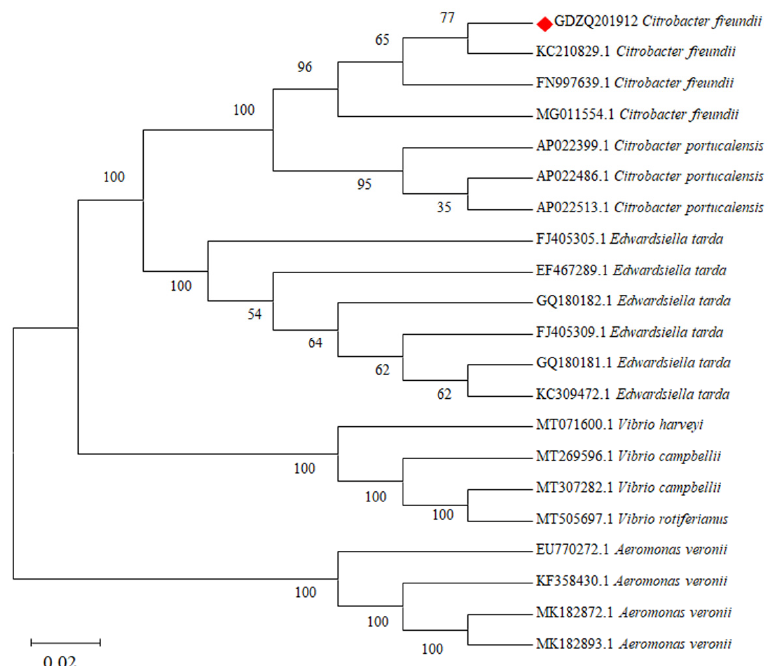
Figure 3. Phylogenetic tree analysis of Citrobacter sp. and other pathogenic bacterium species based on 16S rRNA nucleotide sequences. The tree was generated using NJ method by the MEGA 7 software. Bootstrap values above 50% are shown at the nodes. The isolate strain GDZQ201912 identified in this study is indicated by the red shaded diamond.